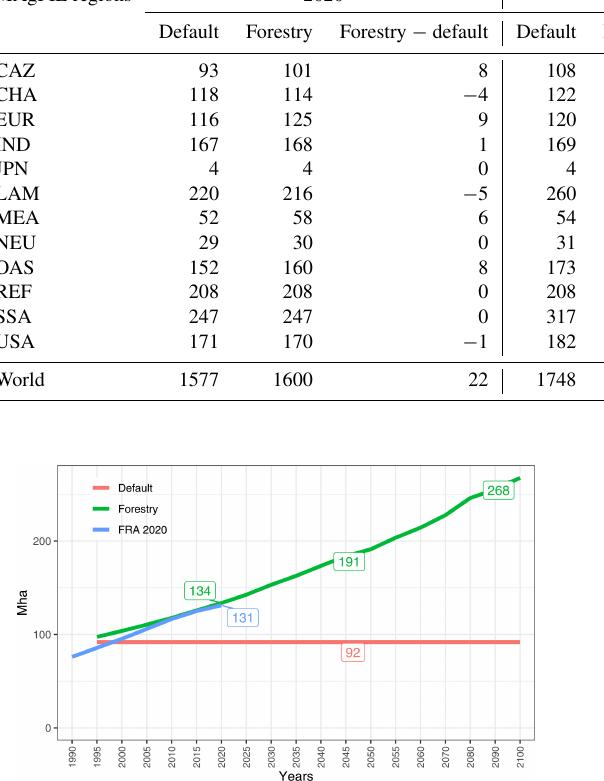
Table 3. Absolute differences in cropland area (in Mha) between the forestry and default scenarios. MAgPIE regions